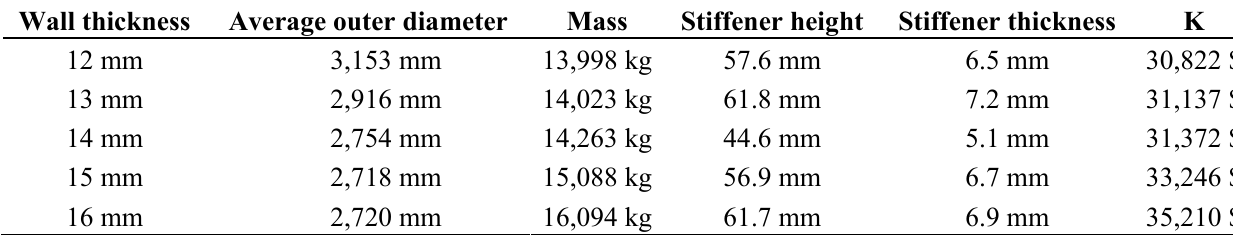
Table 6. Optimization results for the bottom segment.